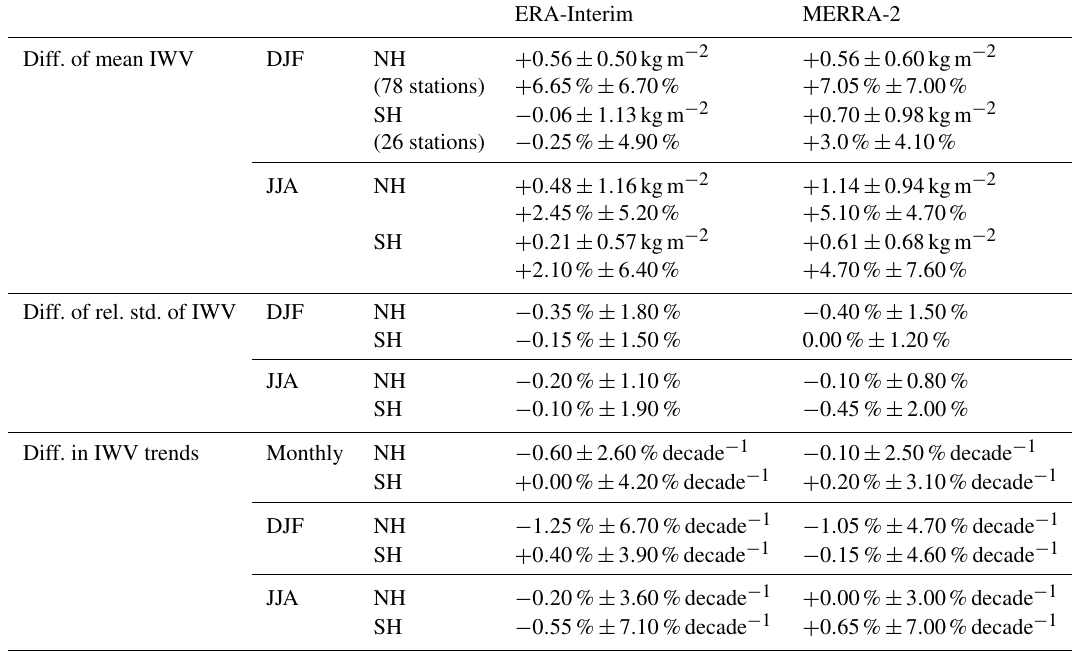
Table 1. Statistics (median ± interquartile range) for the differences (ERA-Interim minus GPS and MERRA-2 minus GPS) at the 104 stations, divided by season and hemisphere, for the differences in IWV mean, relative standard deviation, and trends